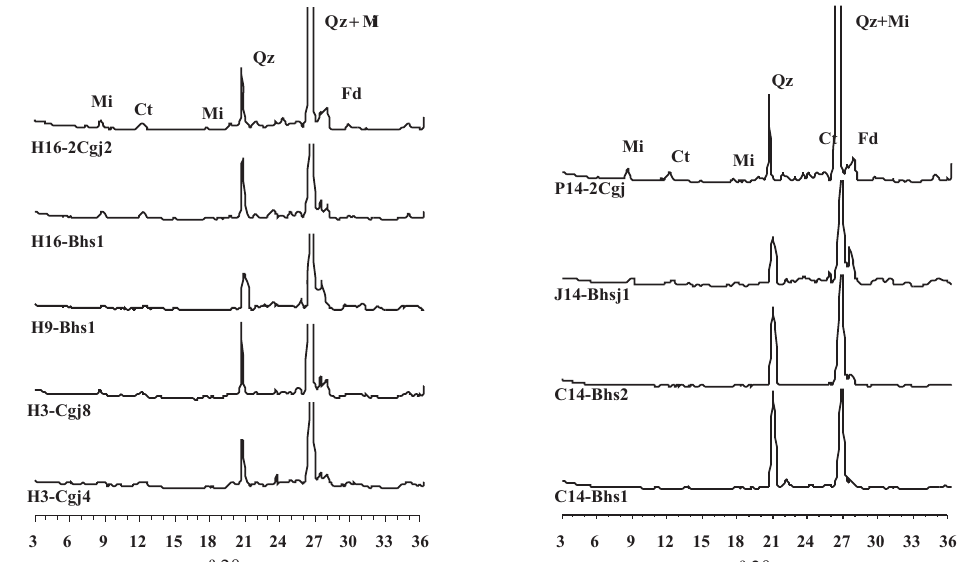
Figura 1. Difratogramas da fração silte dos solos estudados na parcela permanente sob vegetação de mata de restinga do projeto “BIOTA Parcelas Permanentes”, Ilha do Cardoso, Cananéia, SP. Ct: caulinita, Mi: mica, Qz: quartzo, Gb: gibbsita, Es: esmectita, Fd: